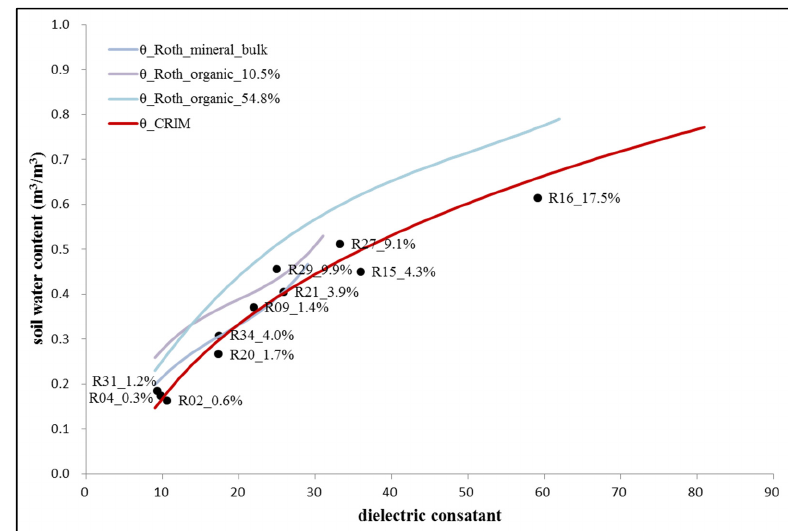
Figure 11. Comparison of organic and mineral calibration curves against our measured soil water content of different organic contents.